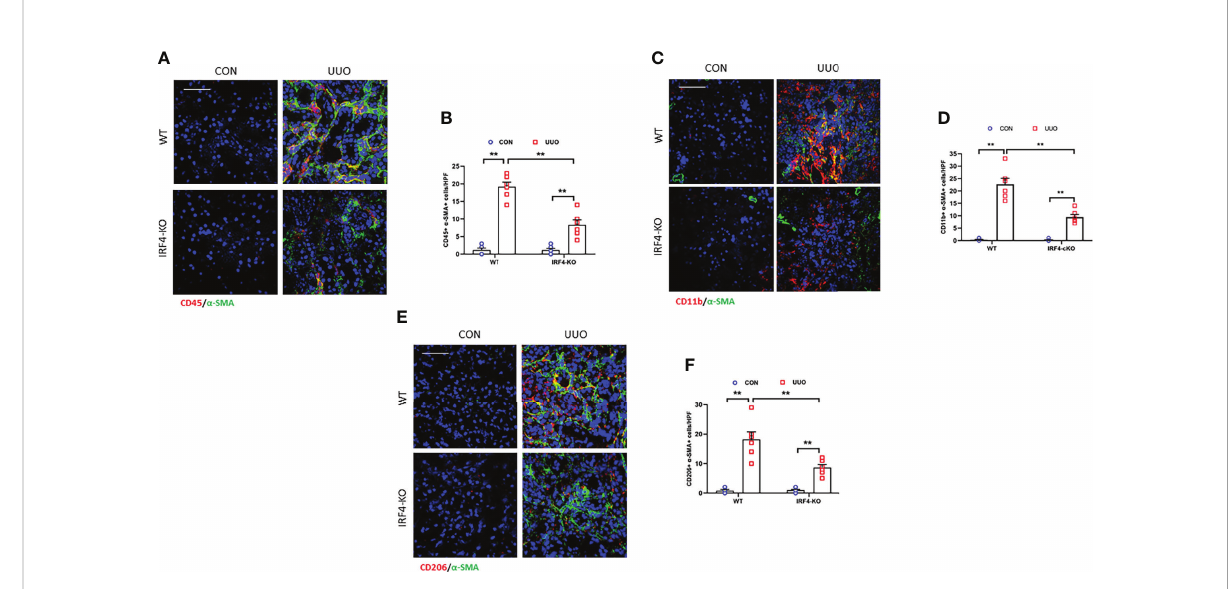
FIGURE 7 IRF4 de fi ciency prevents myeloid fi broblast activation and M2MMT in obstructive kidneys. (A) Kidney sections were stained for CD45 (red) and a -SMA (green). (B) Quantitative analysis of CD45 + - a -SMA + cells. (C) Kidney sections were stained for CD11b (red) and a -SMA (green). (D) Quantitative analysis of CD11b + - a -SMA + cells. (E) Kidney sections were stained for CD206 (red) and a -SMA (green). (F) Quantitative analysis of CD206 + - a -SMA + cells in the kidneys. ** P <0.01; n = 6; Bar = 50 m m. M2MMT, M2 macrophage to myo fi broblast transition; WT, wild-type; KO, knockout; HPF, high-power fi